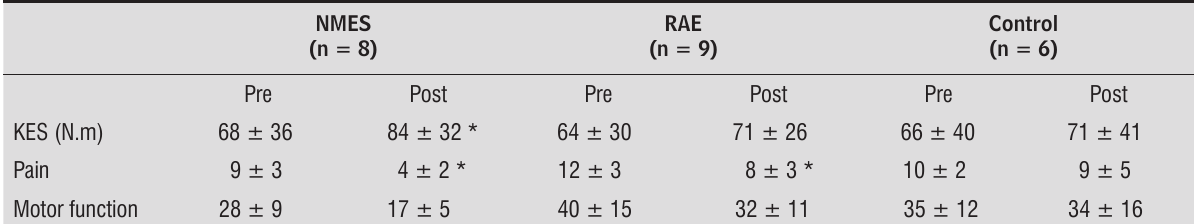
Tabela 1 – Knee extensor strength pain, and motor function before and after the 24-session program for neuromuscular electrical stimulation, resistance against exercise, and control NMES